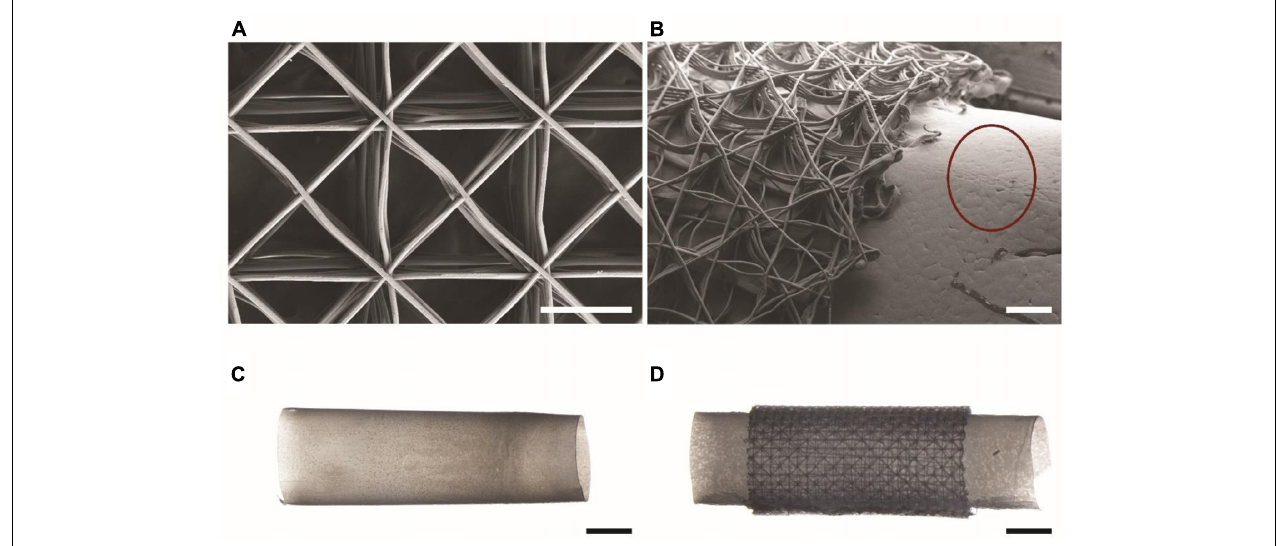
FIGURE 2 | Mock drivelines manufactured by melt electrowriting (MEW). SEM images of (A) a MEW scaffold used for constructing porous mock drivelines and (B) a porous mock driveline showing the MEW scaffold fused to the PCL tube (scale bars: 300 µ m). The red circle highlights the surface morphology of the smooth PCL tube. Stereomicroscope images of (C) a smooth PCL tube and (D) a porous driveline (MEW scaffold – PCL tube) construct. Scale bars: 2 mm.